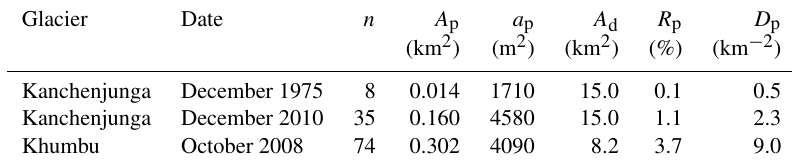
Table 2. Statistics of supraglacial ponds ( ≥ 1000m 2 ) in the debris-covered areas of the Kanchenjunga and Khumbu glaciers. Glacier Date n A p a p A d R p Kanchenjunga